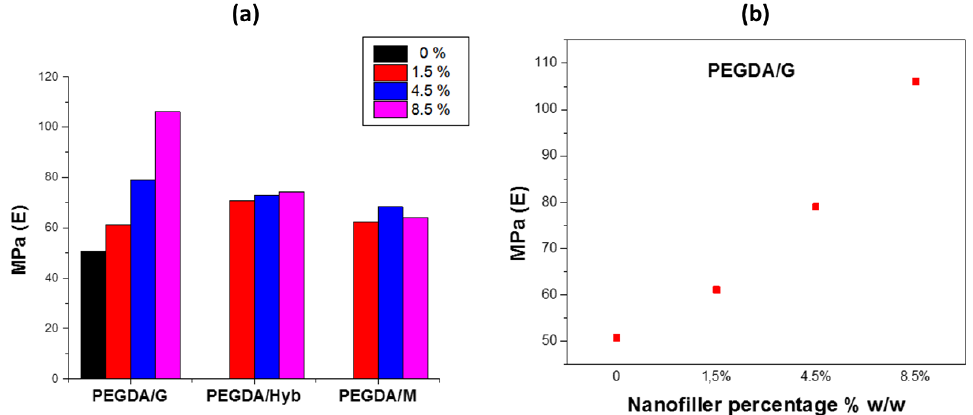
Figure 3. ( a ) Young’s modulus for different mass percentage of all materials. ( b ) Young’s modulus of PEGDA/G composites at different percentages. PEGDA/G composites at different